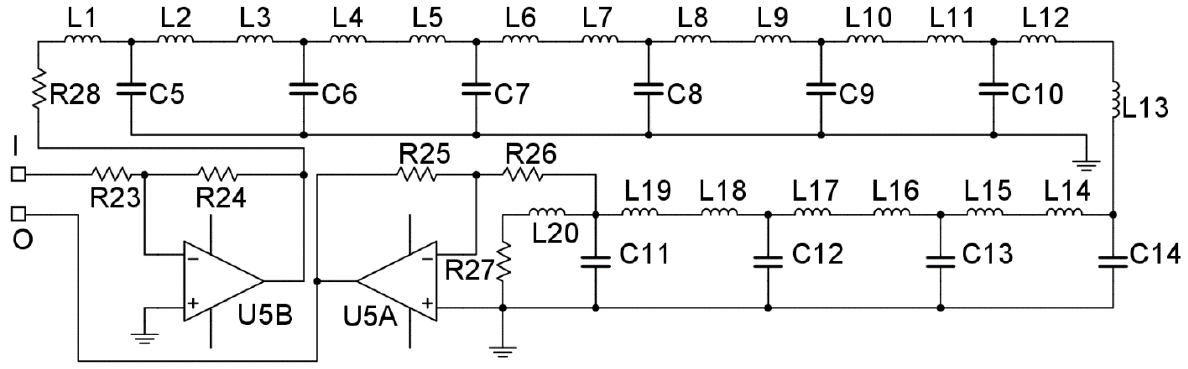
Figure 8. Time-delay module circuit.